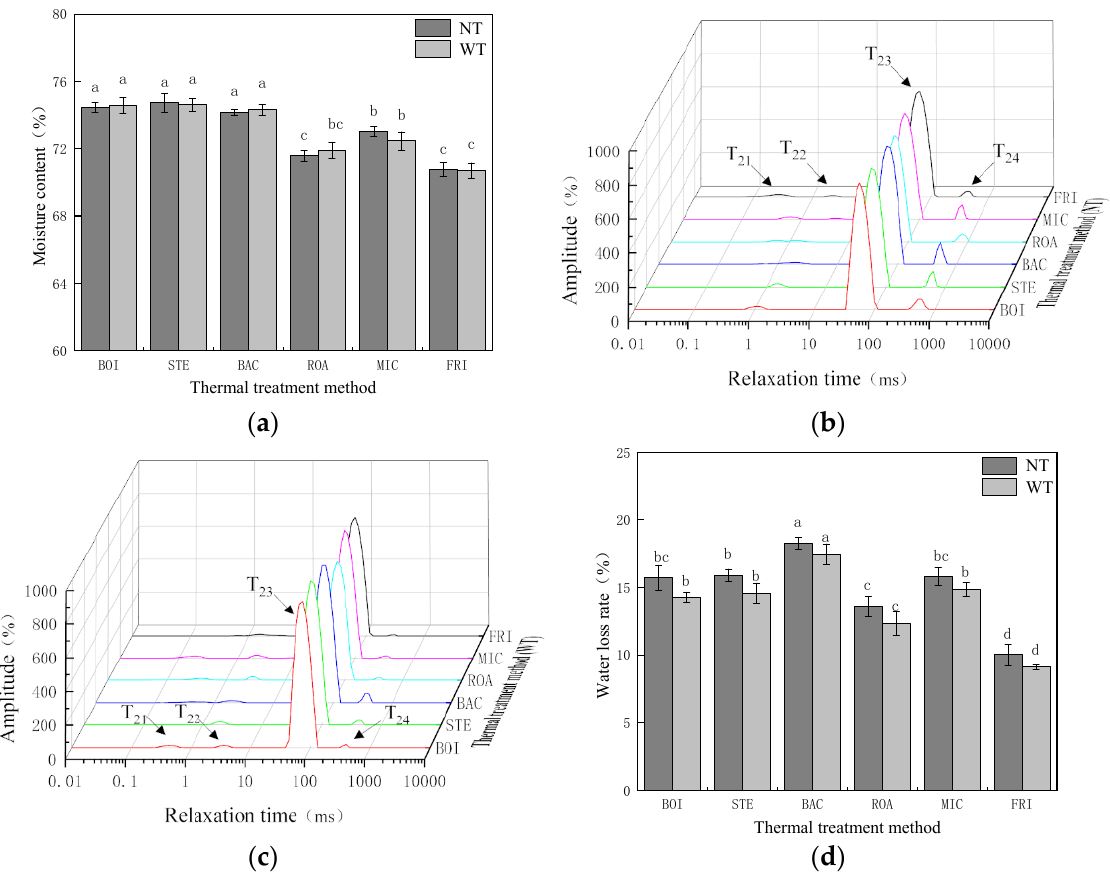
Figure 1. Effect of different thermal treatment methods and the addition of TGase on the moisture retention of D. maruadsi surimi products. ( a ): Moisture content; ( b ): moisture distribution status (NT); ( c ): moisture distribution status (WT); ( d ): water loss rate. BOI: boiled D. maruadsi surimi products; STE: steamed D. maruadsi surimi products; BAC: back-pressure sterilized D. maruadsi surimi products; ROA: roasted D. maruadsi surimi products; MIC: microwaved D. maruadsi surimi products; FRI: fried D. maruadsi surimi products; NT: group of without TGase; WT: group of with TGase. Completely different letters in the same indicator indicate significant differences between the same columns ( p < 0.05).